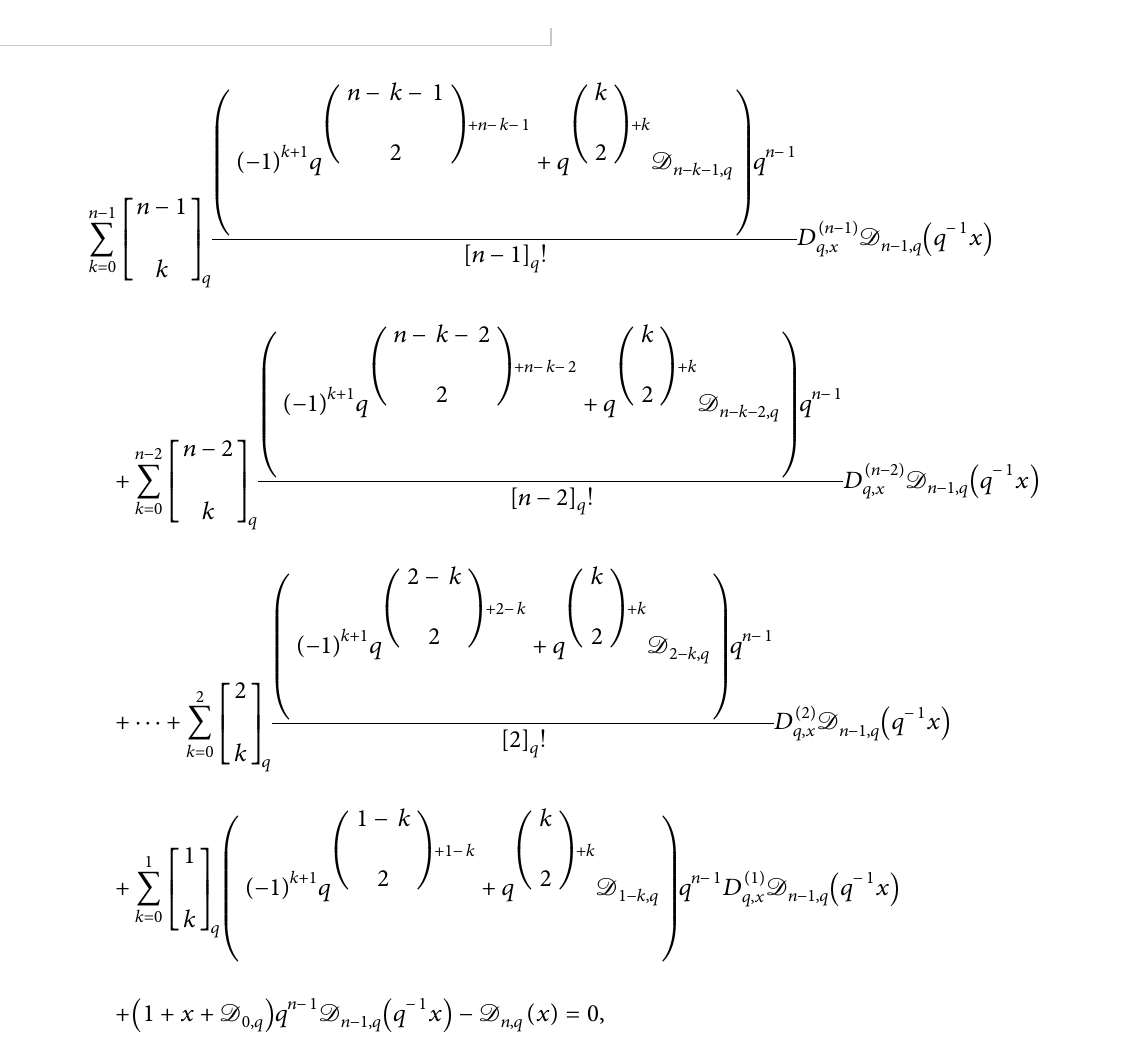
n ≤ 8 and q � 0 . 6 , 0 . 4 , 0 . n,q for 0 ≤